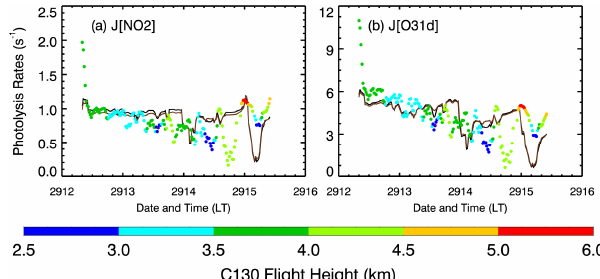
Figure 8 Fig. 8. Comparison of C-130 aircraft measured and calculated pho- tolysis frequencies of J [O 3 ( 1 D)] and J [NO 2 ] along the flight track on 29 March. Dots with different colors: measurements; black line: with the aerosol effect on photolysis frequencies; brown line: with- out the aerosol effect on photolysis frequencies. See Fig. 2 for the x-axis